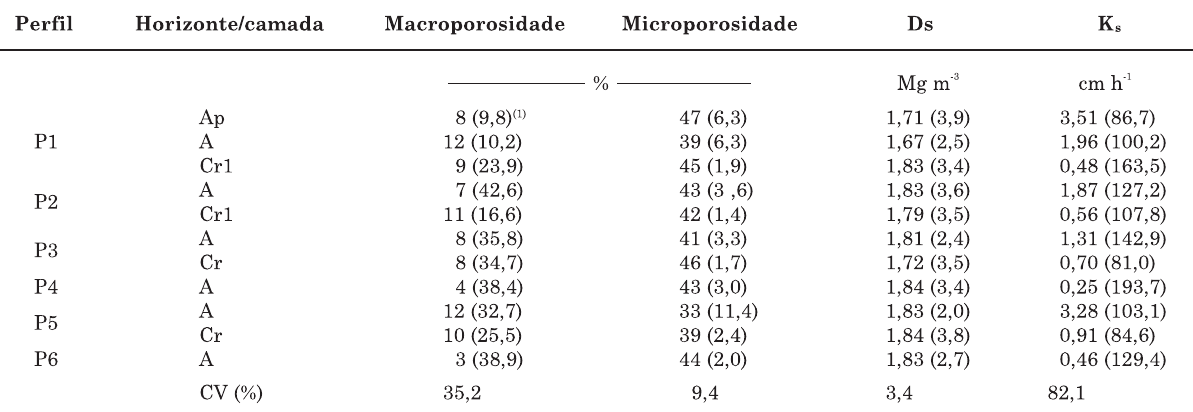
Quadro 4. Porosidade, densidade do solo (Ds) e condutividade hidráulica saturada (K Neossolos Litólicos e Neossolos Regolíticos derivados de arenito da Formação Caturrita no